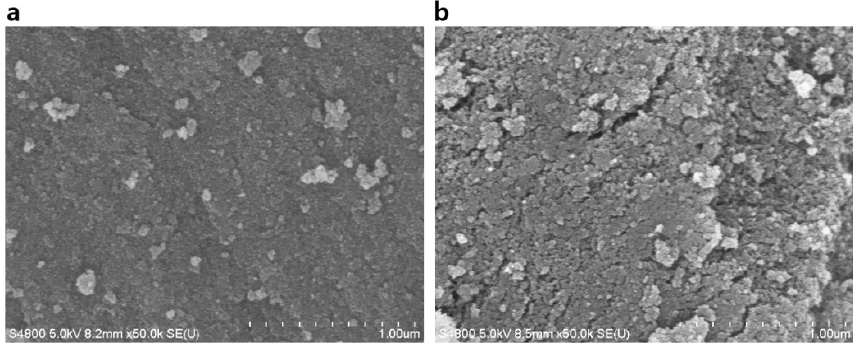
Figure 3. SEM images of PDA-modified aerogel incubated for ( a ) 10 min and ( b ) 24 h.